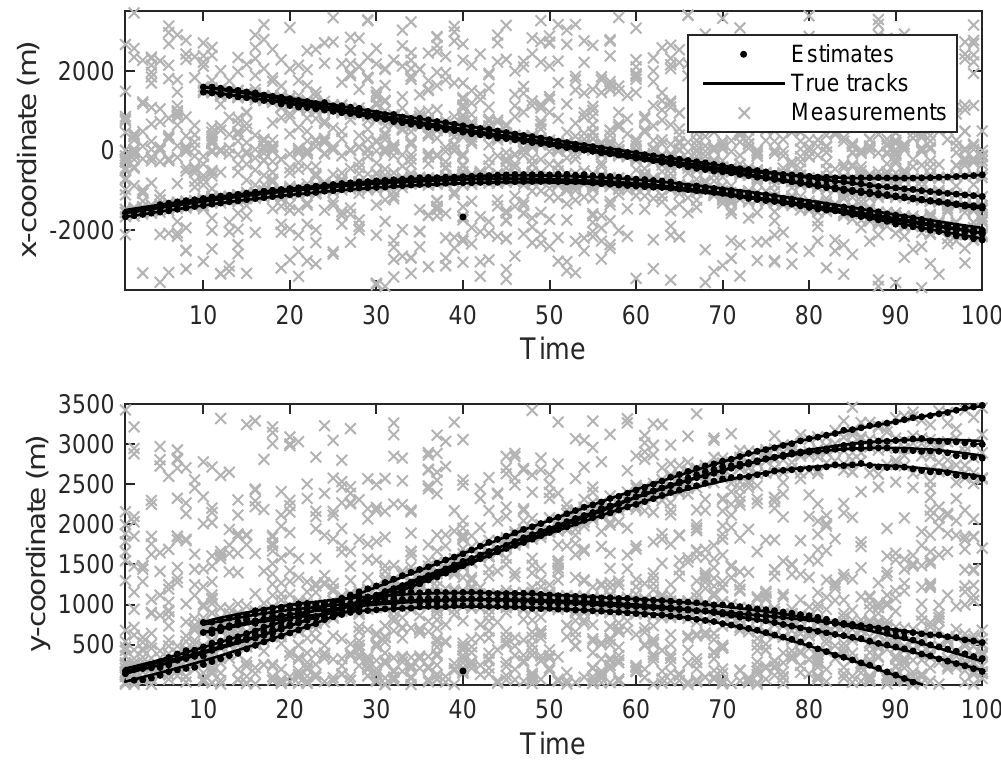
Figure 13. The state estimation by GLMB filter for experiment